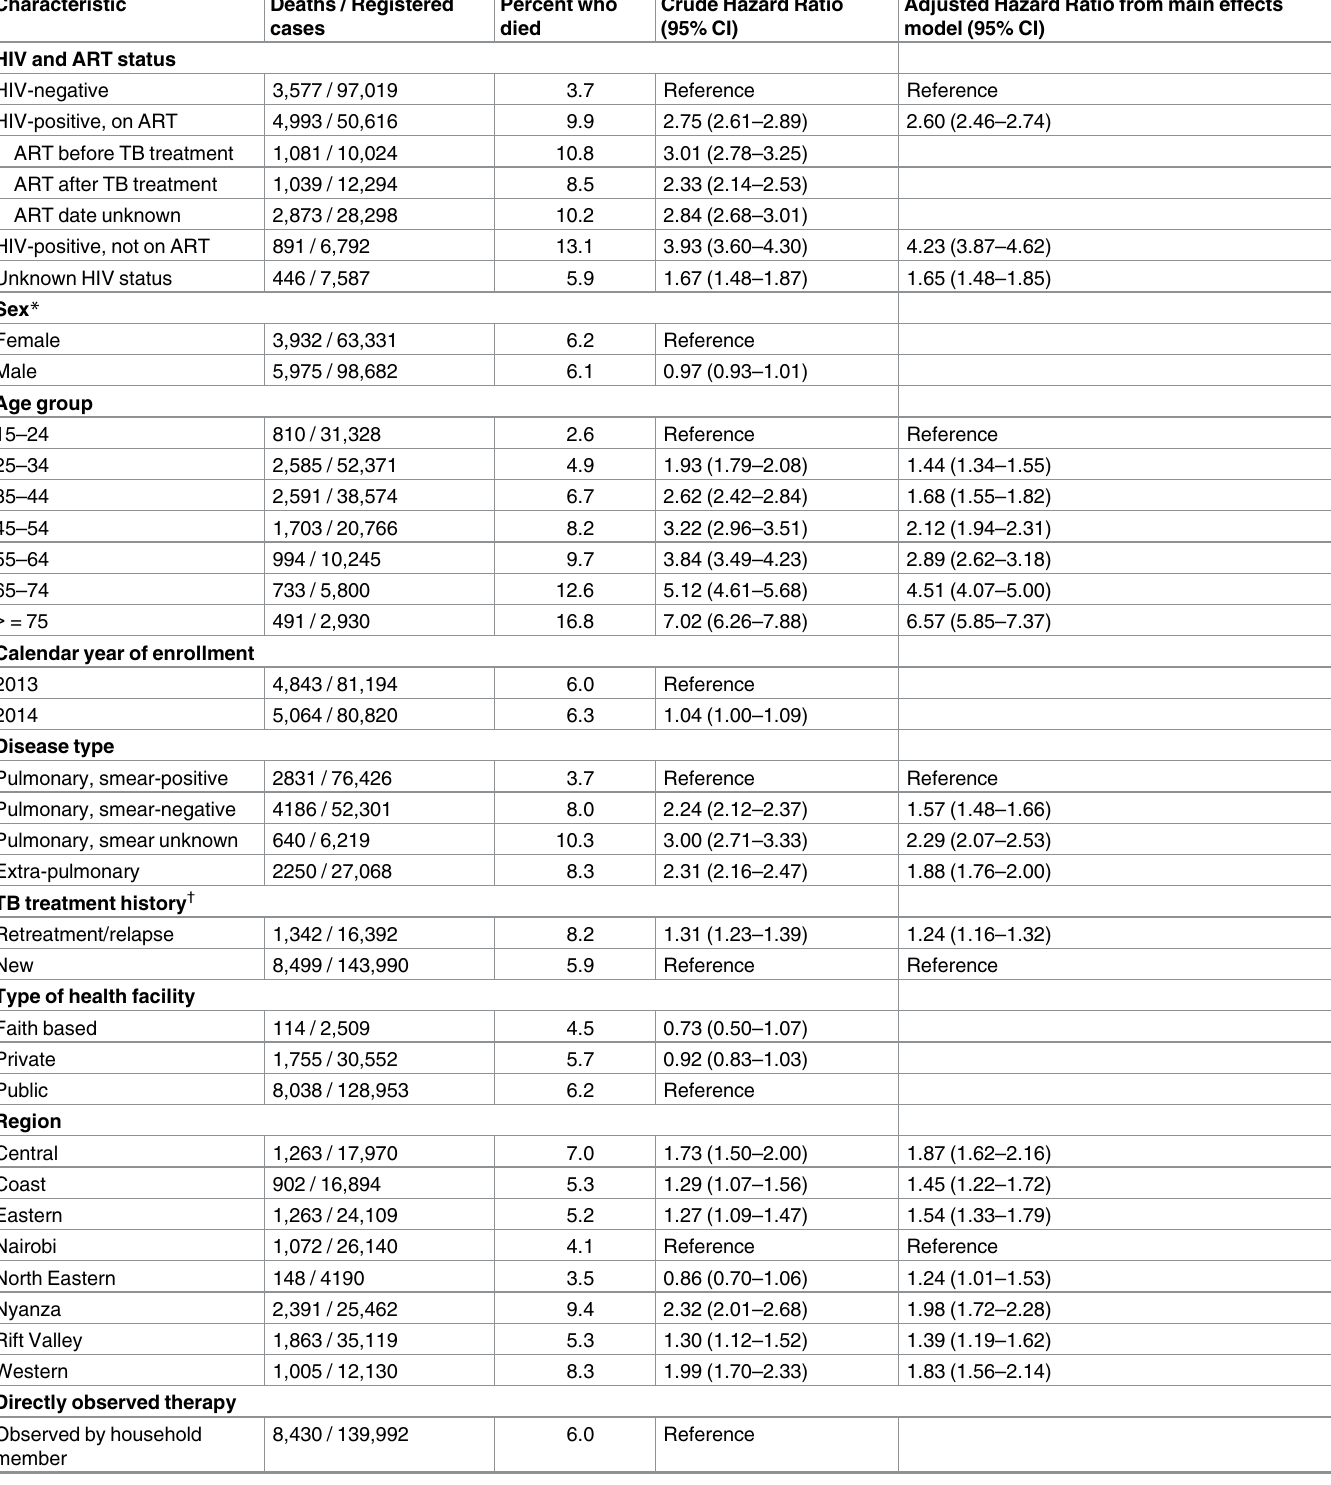
Table 2. Bivariate and multivariable associations between patient characteristics and death among TB patients in